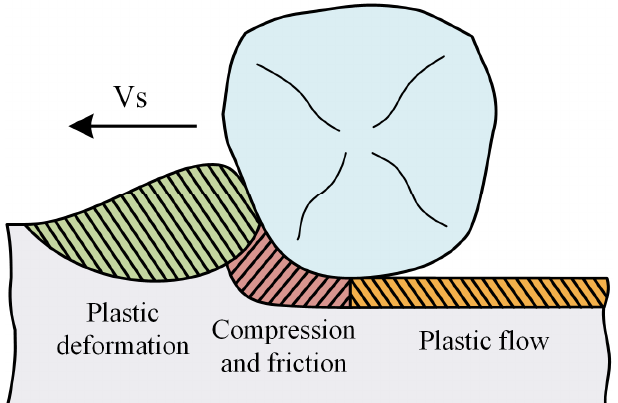
Figure 5. Schematic diagram of plastic flow formation.